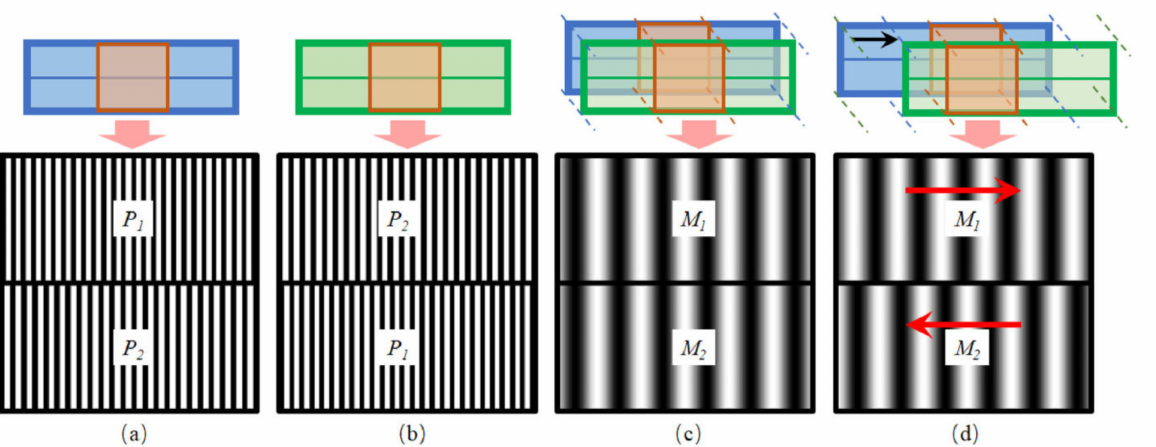
Figure 13. ( a ) Alignment of wafer marks, ( b ) alignment marks of mask, ( c ) Fringes of Moire in perfectly aligned wafer and mask and ( d ) Fringes of Moire in imperfectly aligned mask and wafer. Reprinted with permission from [136]. Copyright 2021,